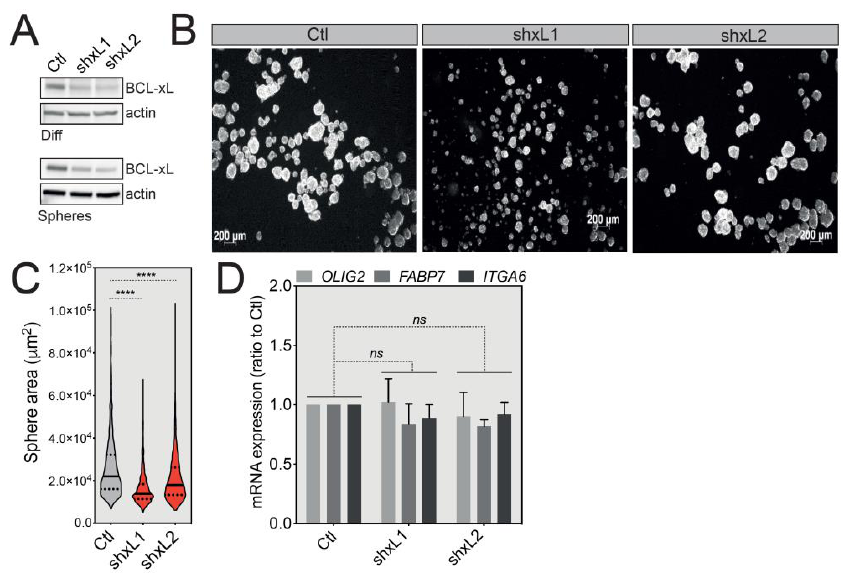
Figure 4. BCL-xL knockdown reduces GBM tumorsphere size. ( A ) Western blot analysis of